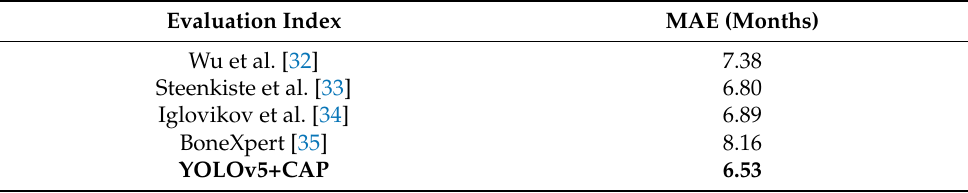
Table 2. Comparison with different methods on the RASA